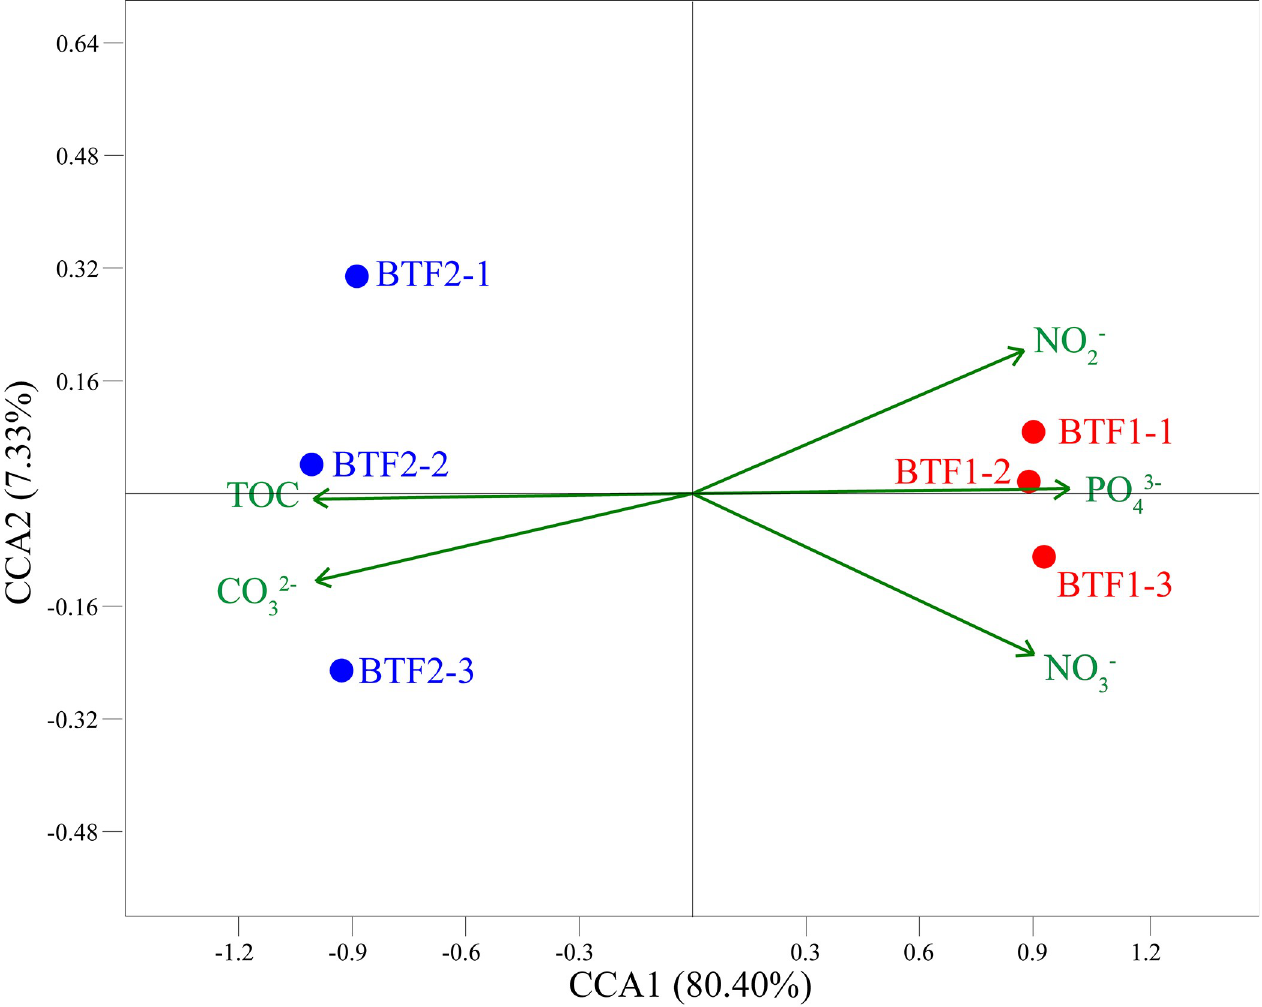
Fig 2. Species-parameter biplot displaying samples from the two BTFs on day 11 with respect to environmental parameters based on CCA.